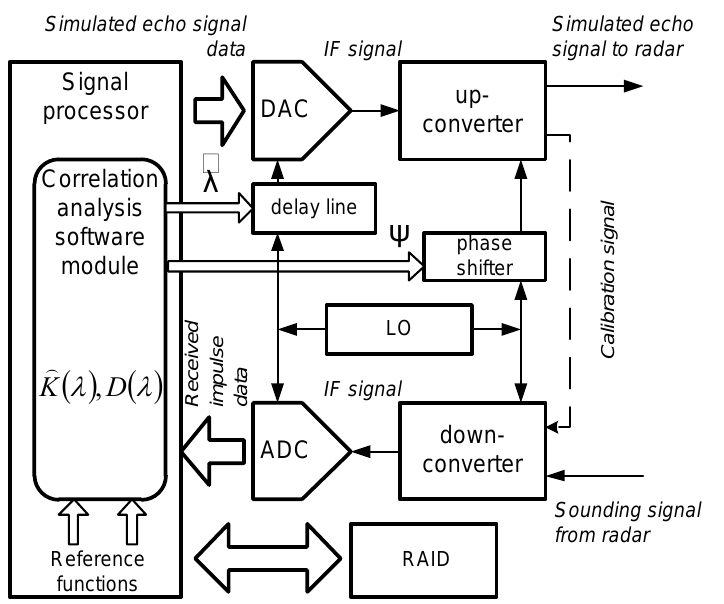
Fig. 3. The block diagram of the active simulator of arbitrary radar